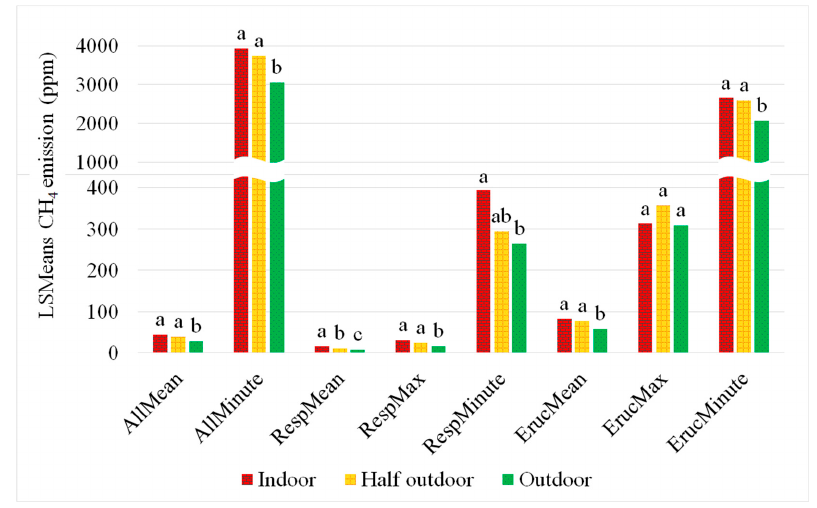
Figure 4. Least square means (LSMeans) for the methane traits in indoor, half-outdoor and outdoor classes. Different letters on bars indicate significant differences ( p- value < 0.05).